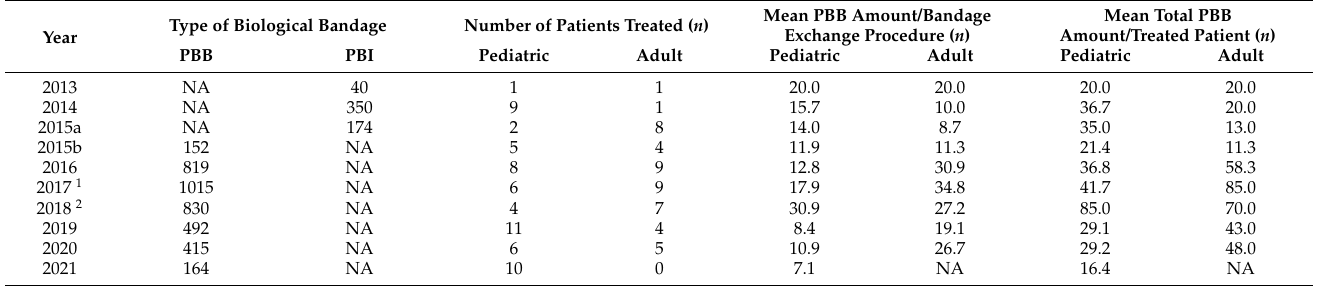
Table 3. Overview of clinical applications of PBI and PBB constructs in adult and pediatric patient populations between 2013 and 2021 in the Lausanne burn center (i.e., for primary burn wounds or for skin donor site wounds). Extreme clinical cases where patients have received the highest recorded product doses are mentioned. NA, non-applicable; PBB, progenitor biological bandage; PBI, progenitor biological bandage yielding γ -irradiated cells; TBSA, total body surface